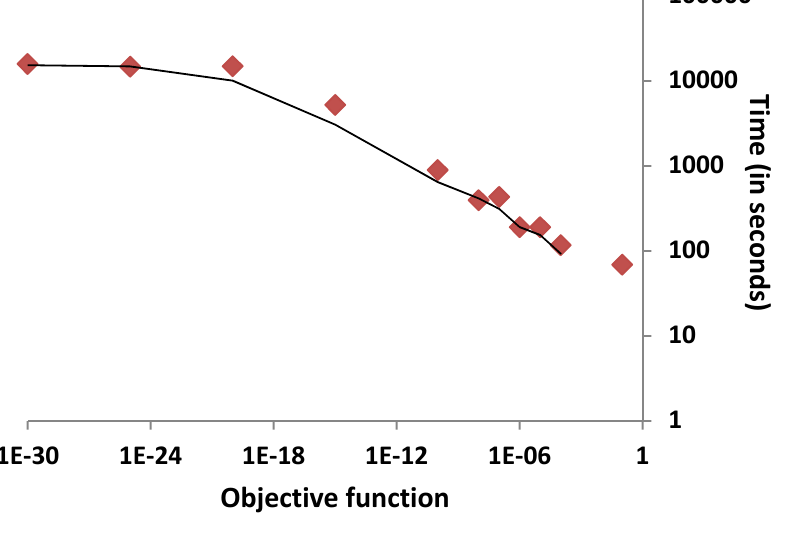
Figure 5. Computing times of parameter variability analysis (PVA) against changes in objective function. PVA was performed for a reaction with two substrates, two products, one enzyme and six kinetic parameters. For each PVA run, the summed squared mean distance measured between the simulated data and input data, known as the objective function, was set and the time taken to compute PVA results (running the genetic algorithm 100 times) was recorded. The results indicate a linear relation between the objective function and the computing time until the limits of computational precision are reached. Both axes of the graph are in logarithmic